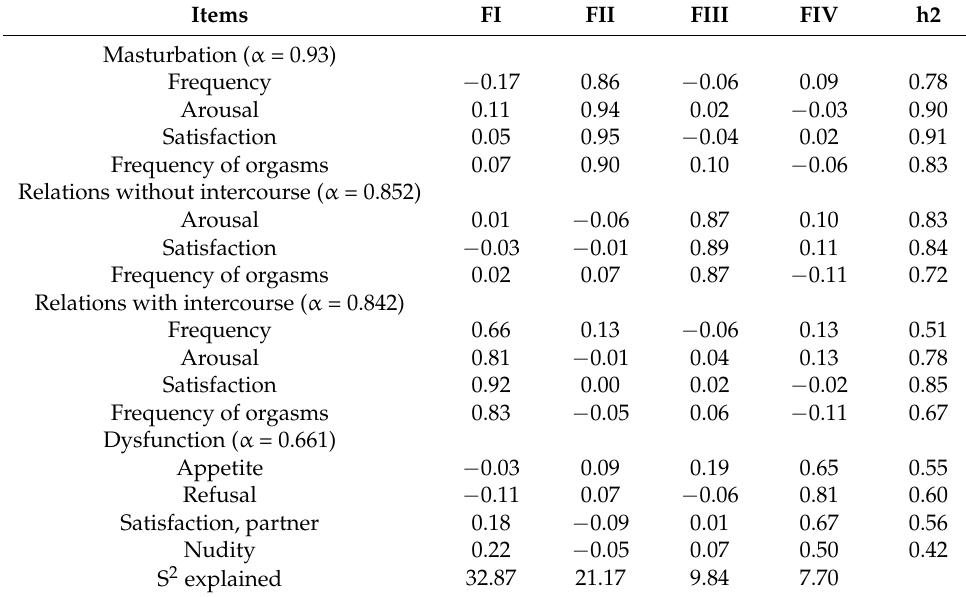
Table 3. Item analysis and internal consistency of the factors. S 2